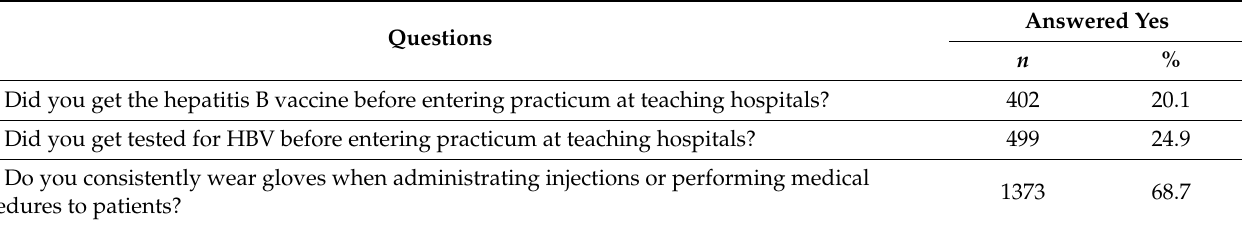
Table 4. HBV Preventive Practices ( n = 2000).